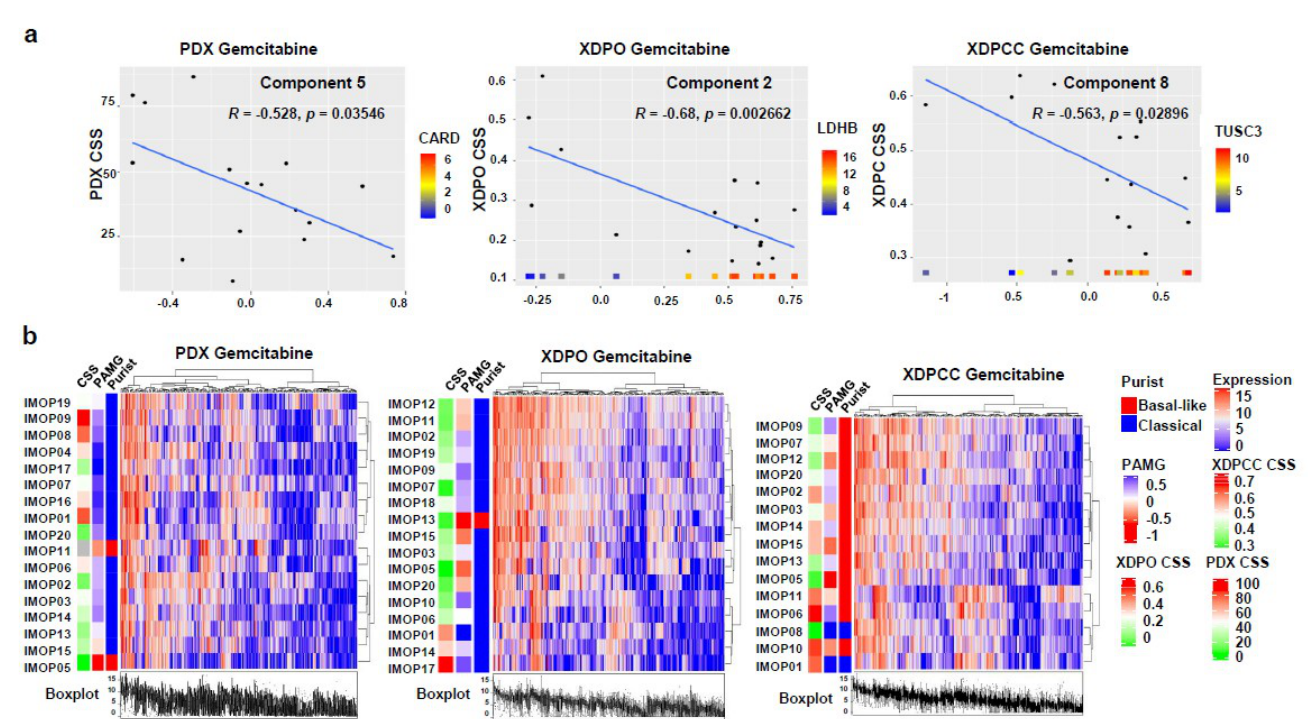
Figure 4. Gemcitabine chemosensitivity profiles using ICA. ( a ) Correlation graph between the best component obtained from the ICA and gemcitabine CSS for PDX, XDPO and XDPCC models. The CSS is displayed on the y -axis and the contribution of the witness gene of the x -axis. All three models show an anti-correlation. Regression (R) values and p-values are displayed. ( b ) Hierarchical clustering for PDX, XDPO and XDPCC gemcitabine sensitivity components are shown respectively. Rows are clustered using model IDs and columns show the clustering of genes. Boxplots located at the bottom of the heatmap show the variation in expression levels for each gene within the component. Annotations to the right and left of the heatmap indicate, the Molecular Grade (PAMG), the PurIST classification and the model type including CSS. A higher CSS indicates more resistance in red and a lower CSS indicates more sensitivity in green. For the Molecular Gradient (PAMG) a higher value means a more classical phenotype ( blue ) and lower values are a more basal-like phenotype ( red ). Binary classification is also provided using the PurIST method for determining the phenotype where red is basal-like and blue is classical.